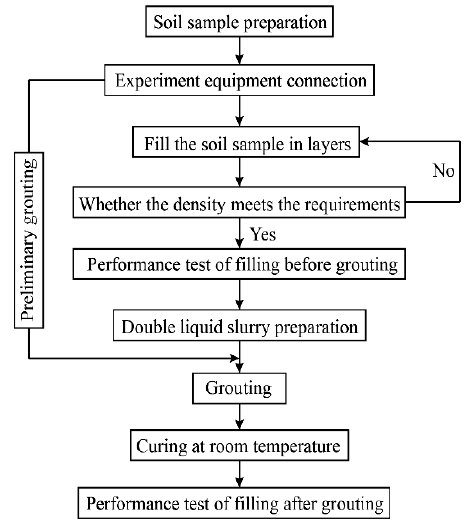
Figure 8. Experimental flow chart.